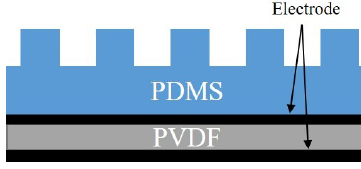
Figure 1. Sensor